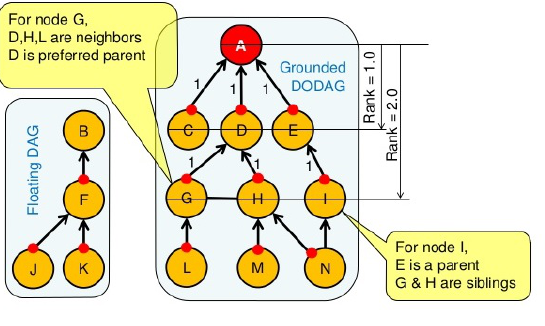
Figure 3. The rank in IoT